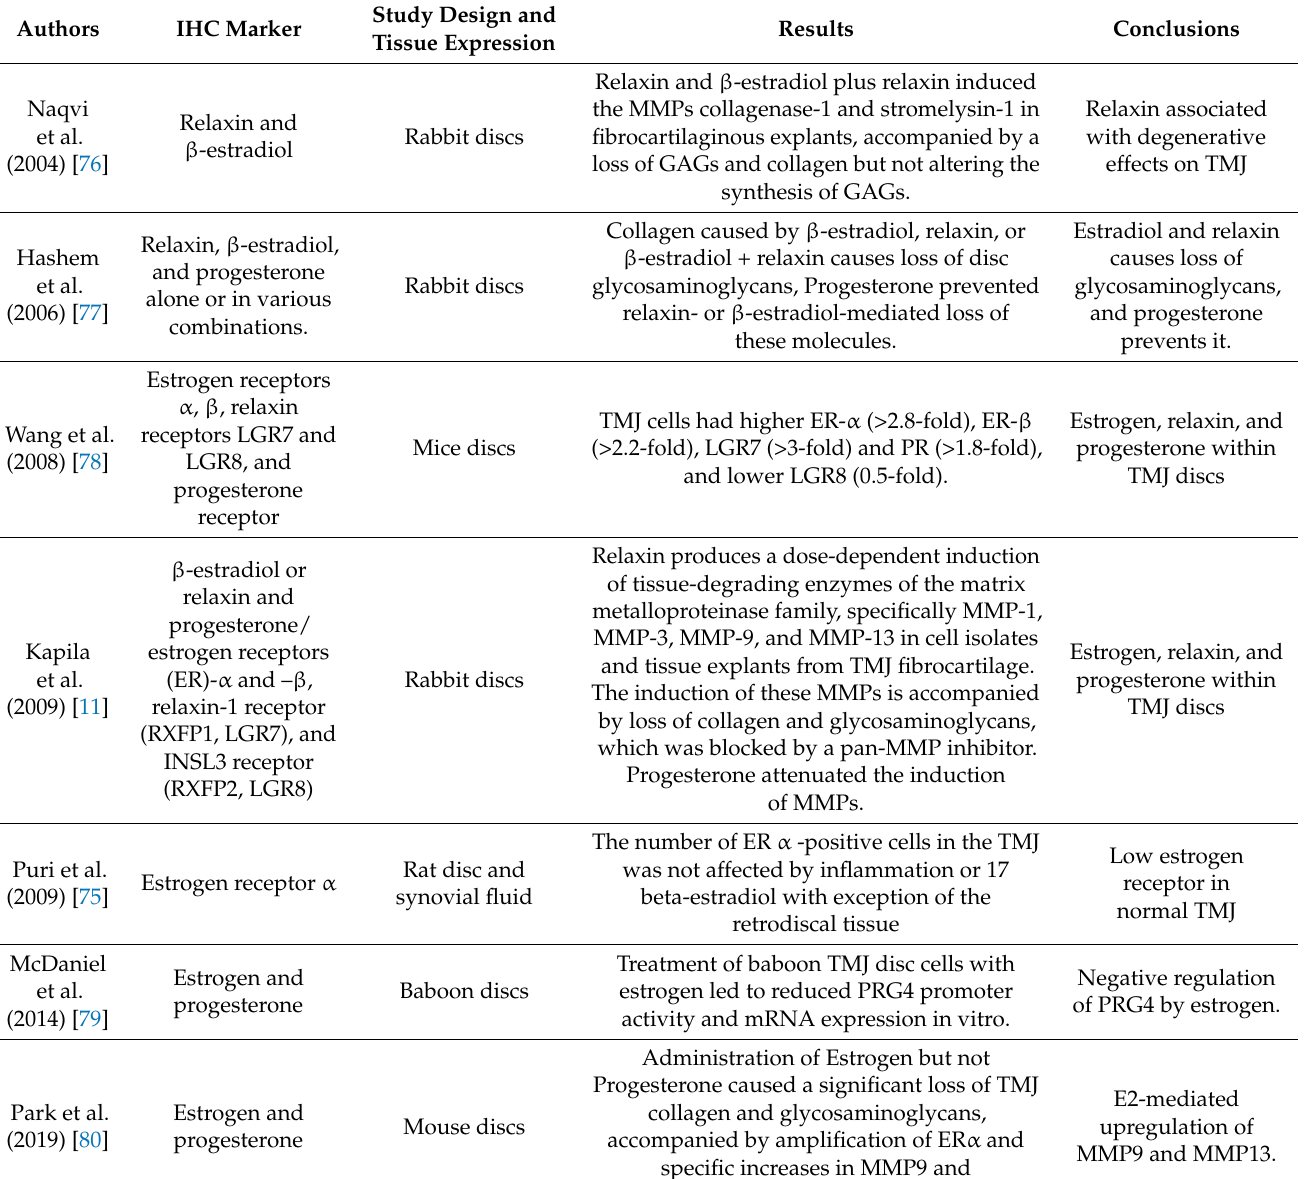
Table 4. Hormones (estrogen, progesterone,